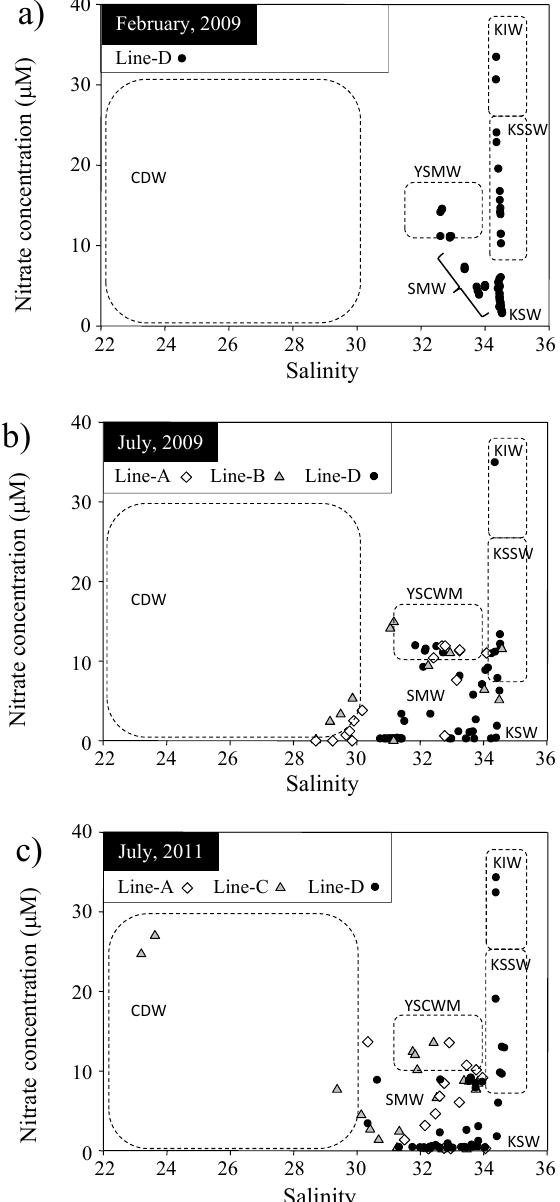
Fig. 7. Relationship between salinity and nitrate concentration in the northern ECS in (a) February 2009, (b) July 2009, and (c) July 2011. The abbreviations of water masses are the same as those in Figure 7 (Umezawa et al.) Fig. 6.